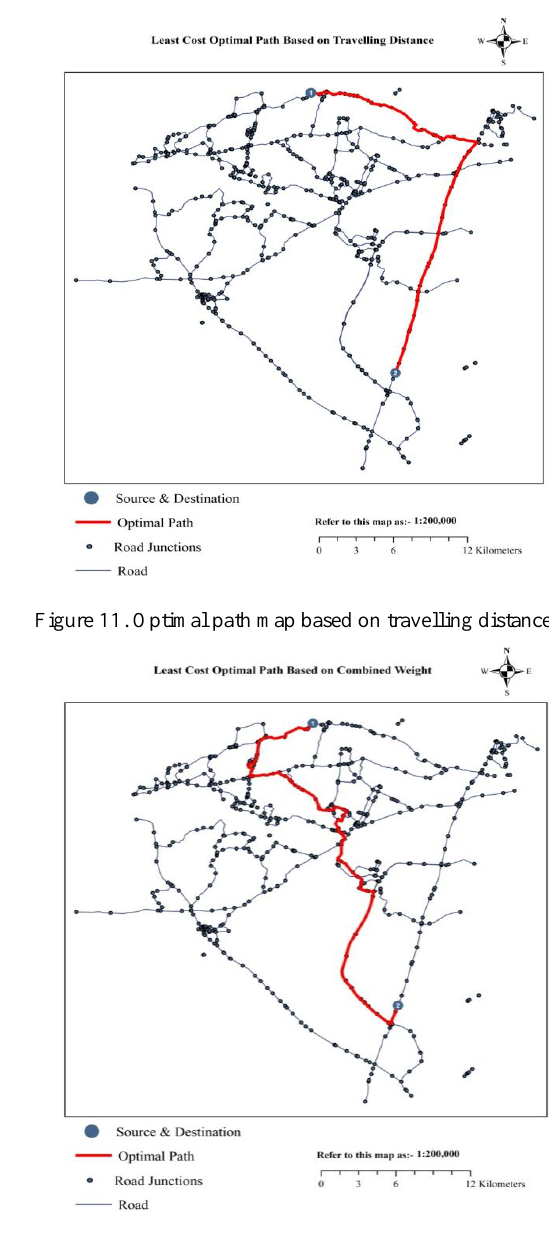
Figure 12. Optimal path based on travelling time map Figure 13. Optimal path based on combine weight